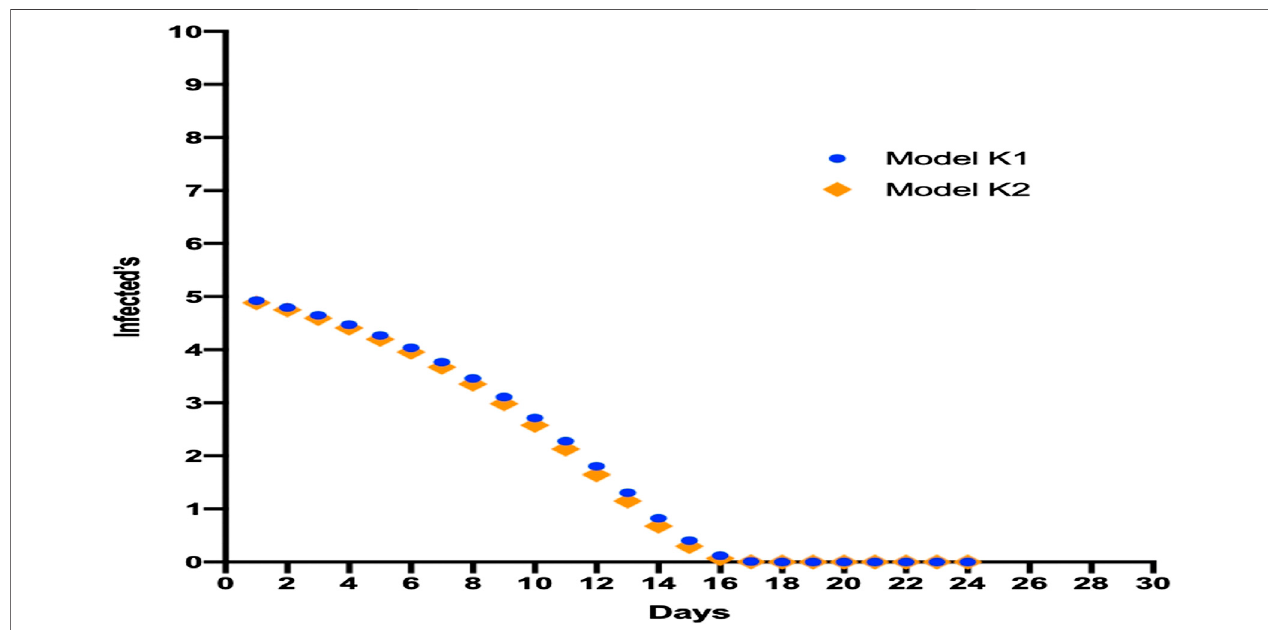
FIGURE 2 | Model for the minimum number of cases required for an epidemic in Ecuador showing different simulations with various K constants for observing this number, communitarian infection, and the average time needed for recovery.